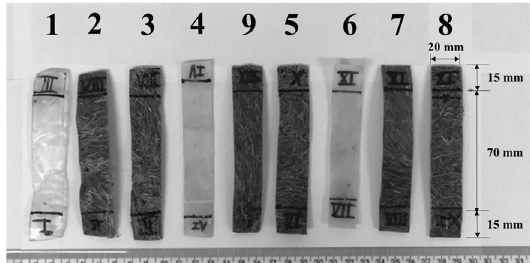
Figure 1. Test specimens of biocomposites for the different essays of the experimental design (digits at the top correspond to essay number in Table